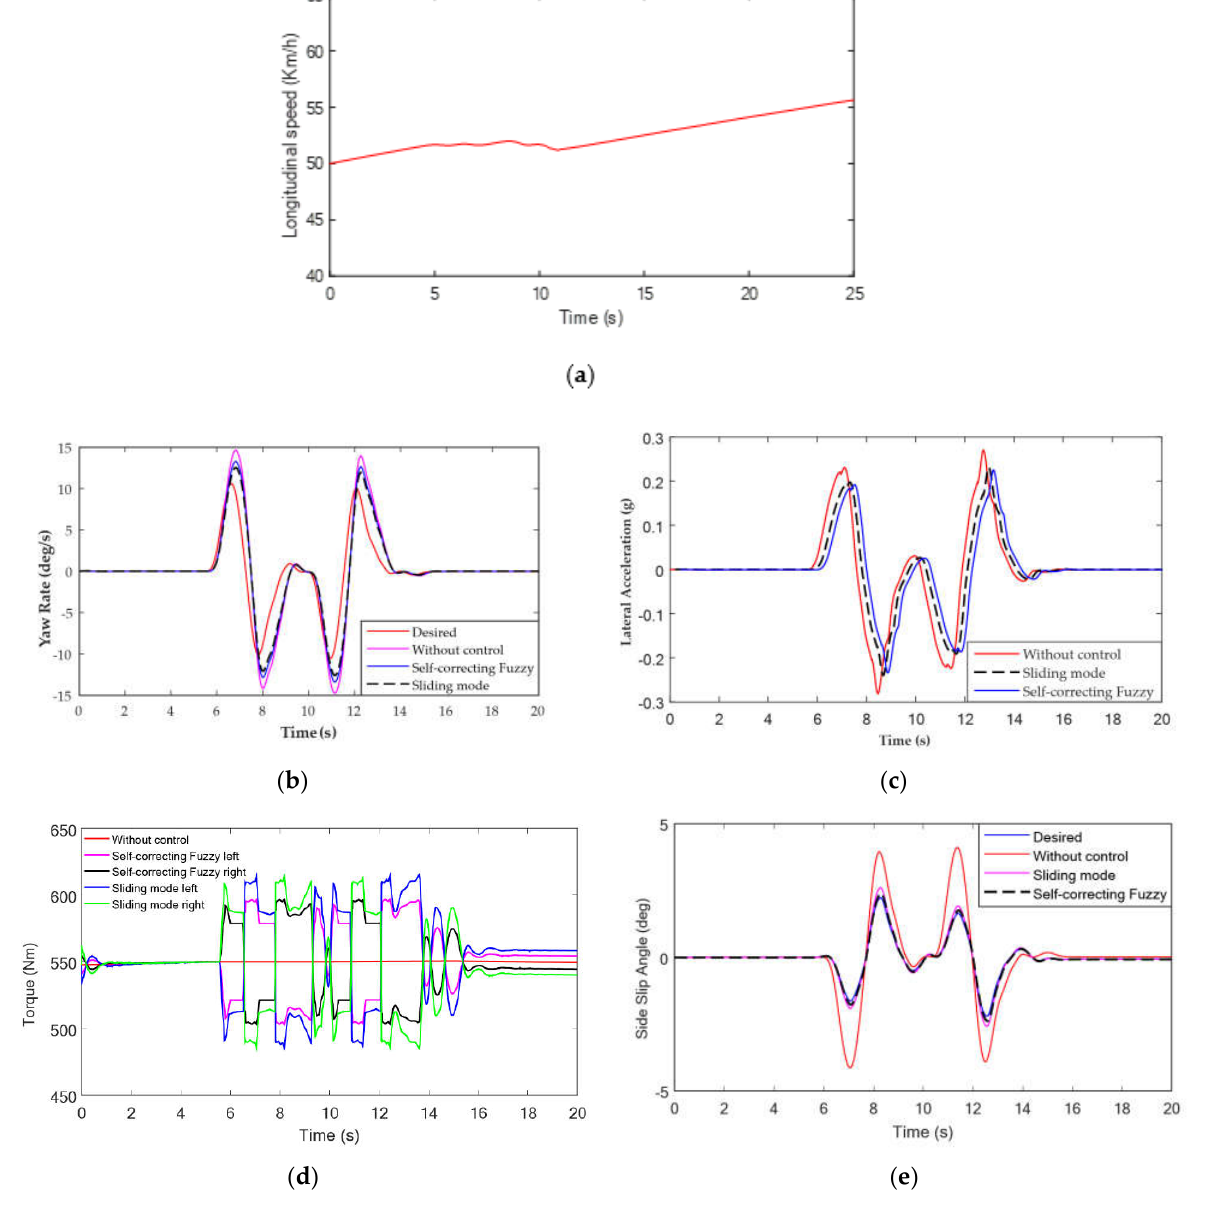
Figure 12. Simulation results of the distributed drive control at the double shift line condition: ( a ) Speed; ( b ) Yaw Rate; ( c ) Lateral Acceleration; ( d ) Torque; ( e ) Sideslip Angle.